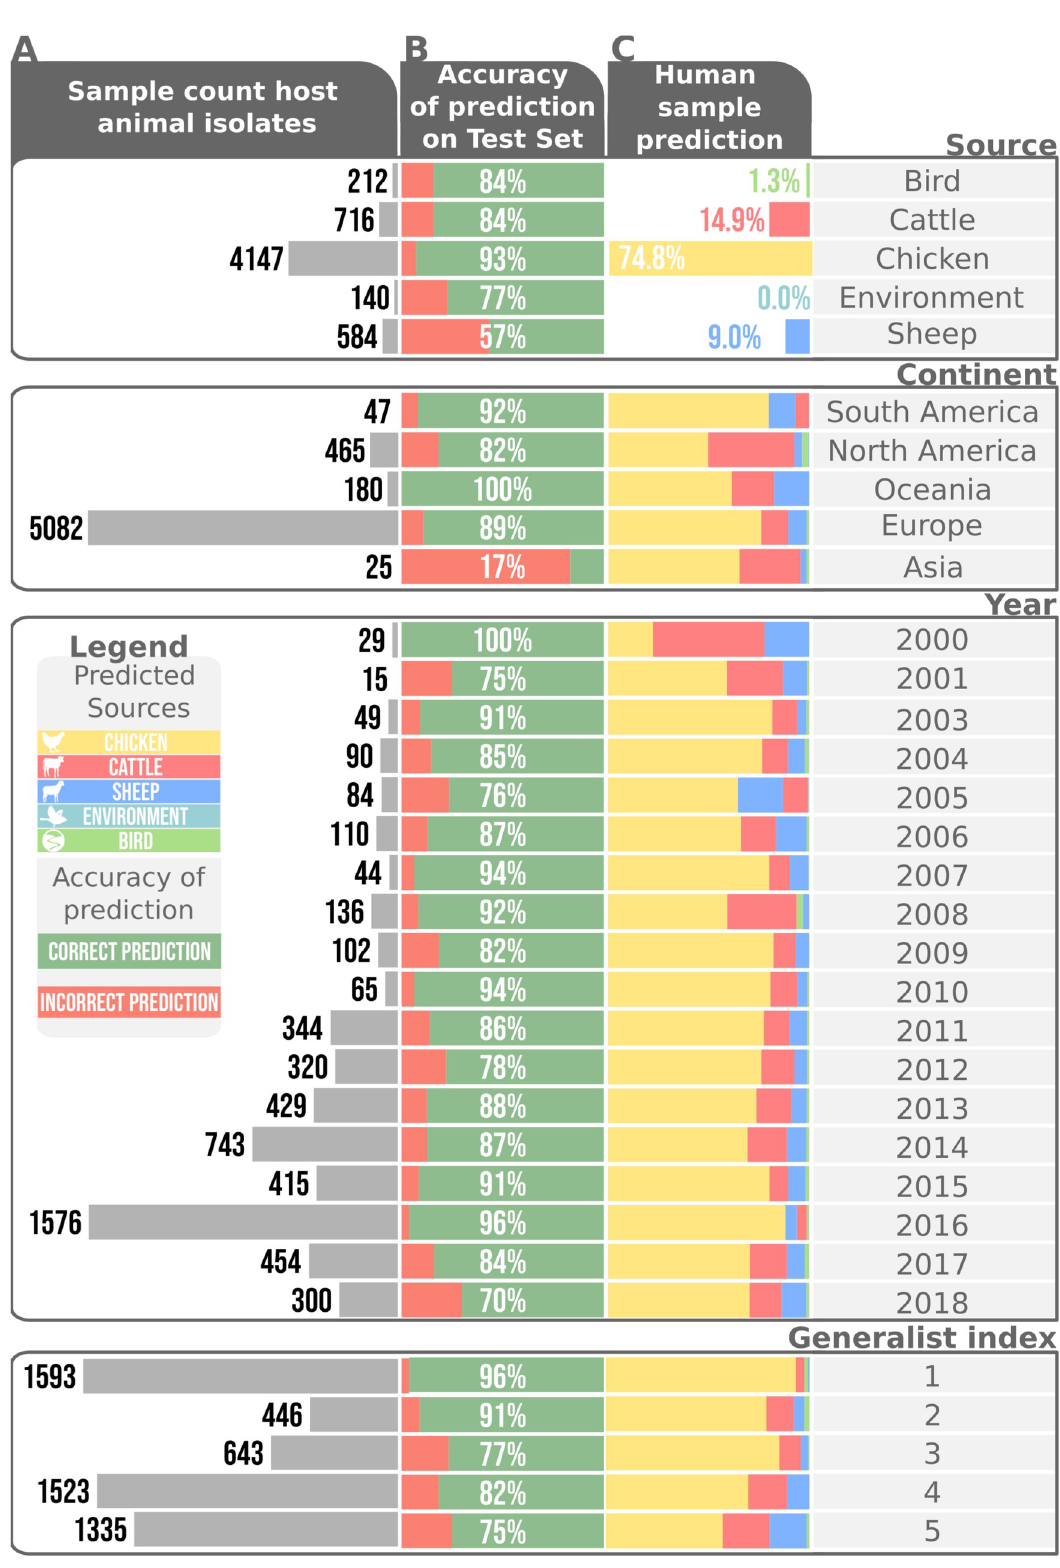
Fig 3. Source attribution per source, continent, year generalist index and Campylobacter species. A) Sample sizes across different factors in the imbalanced training set. B) Prediction accuracy on the full test dataset divided by different factors. C)